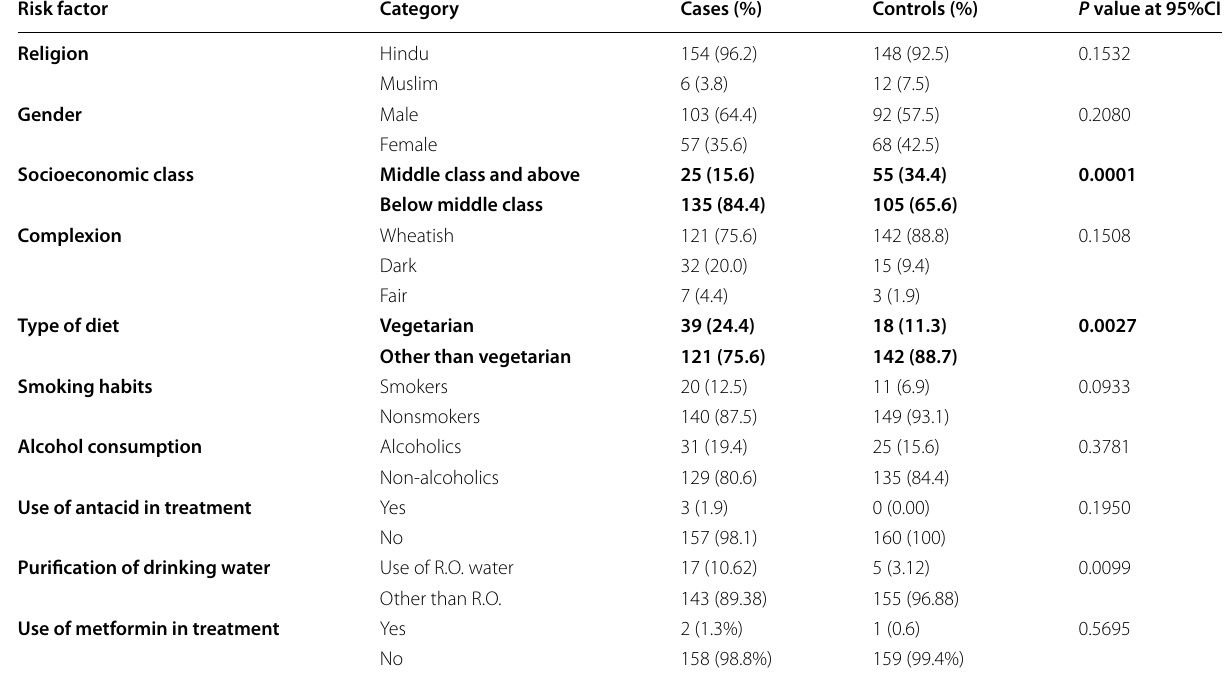
Table 2 Risk factors and associated vitamin B12